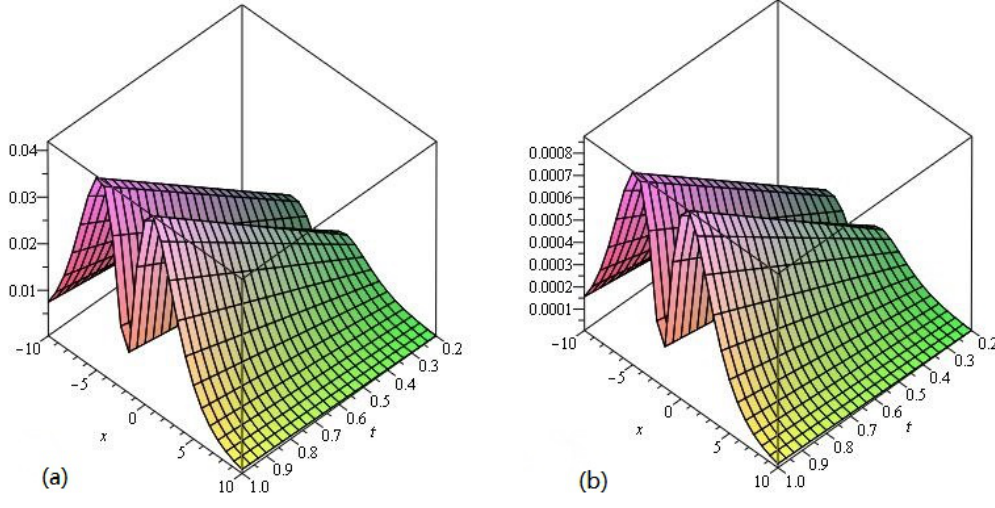
Figure 1. The LADM solution of ( a ) u ( x 1 , t 1 ) and ( b ) v ( x 1 , t 1 ) of Example 1 at γ = 1.